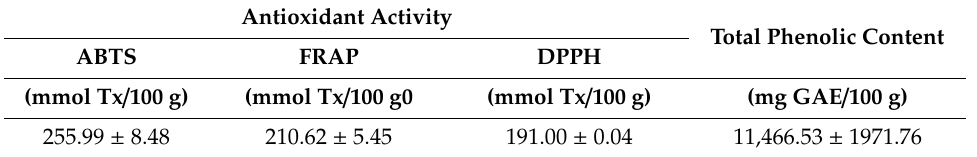
Table 2. The results of antioxidant activity and total phenolic content assays of the extract of